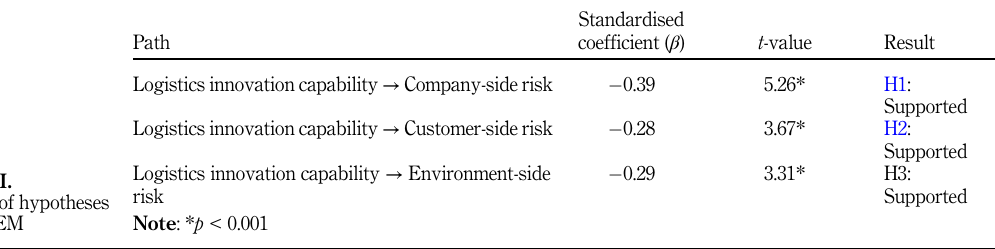
Table II. Results of hypotheses using